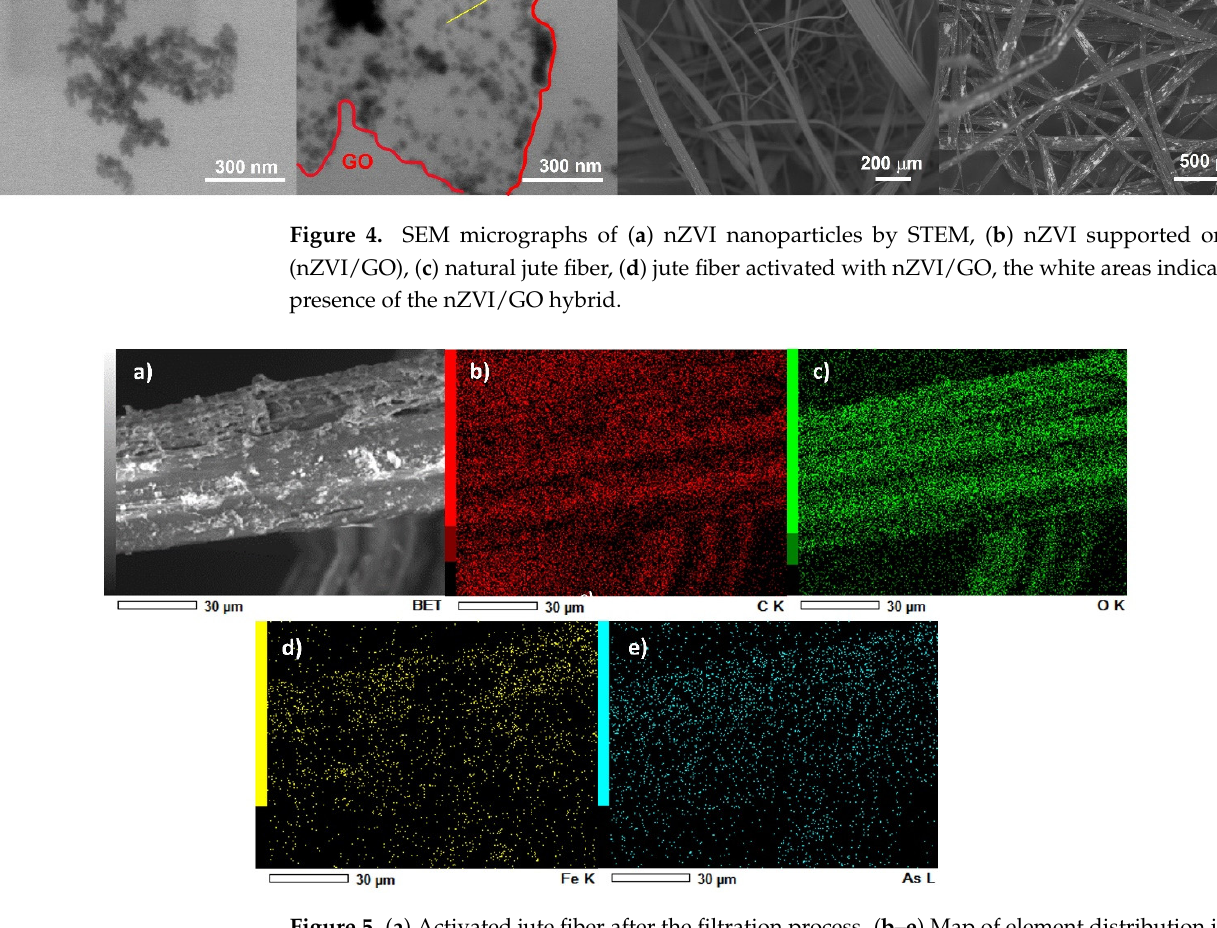
Figure 5. ( a ) Activated jute fiber after the filtration process. ( b – e ) Map of element distribution in jute fiber activated by SEM-EDS. Red: carbon, green: oxygen, yellow: iron, and blue: arsenic.